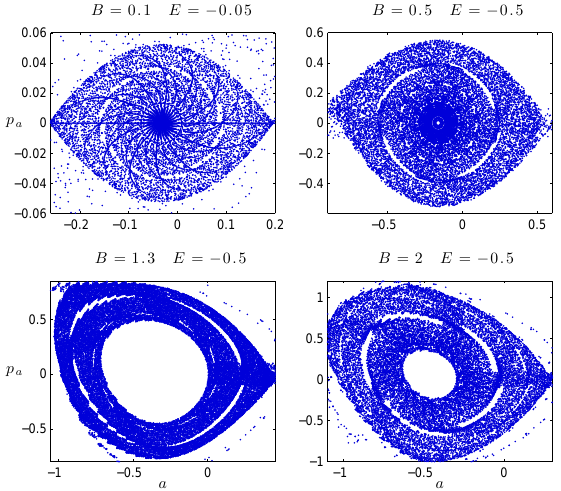
Figure 4. A sample of SOS plots for different values of the magnetic field strength and energy. The values of the magnetic field B and the energy of the ensemble E are marked on top of the figures. Electric field strength F is set to 1 in all four